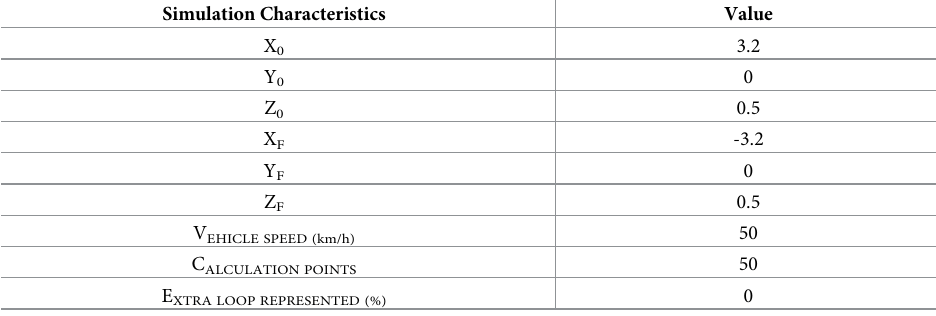
Table 6. Citroe¨n C-15 simulation